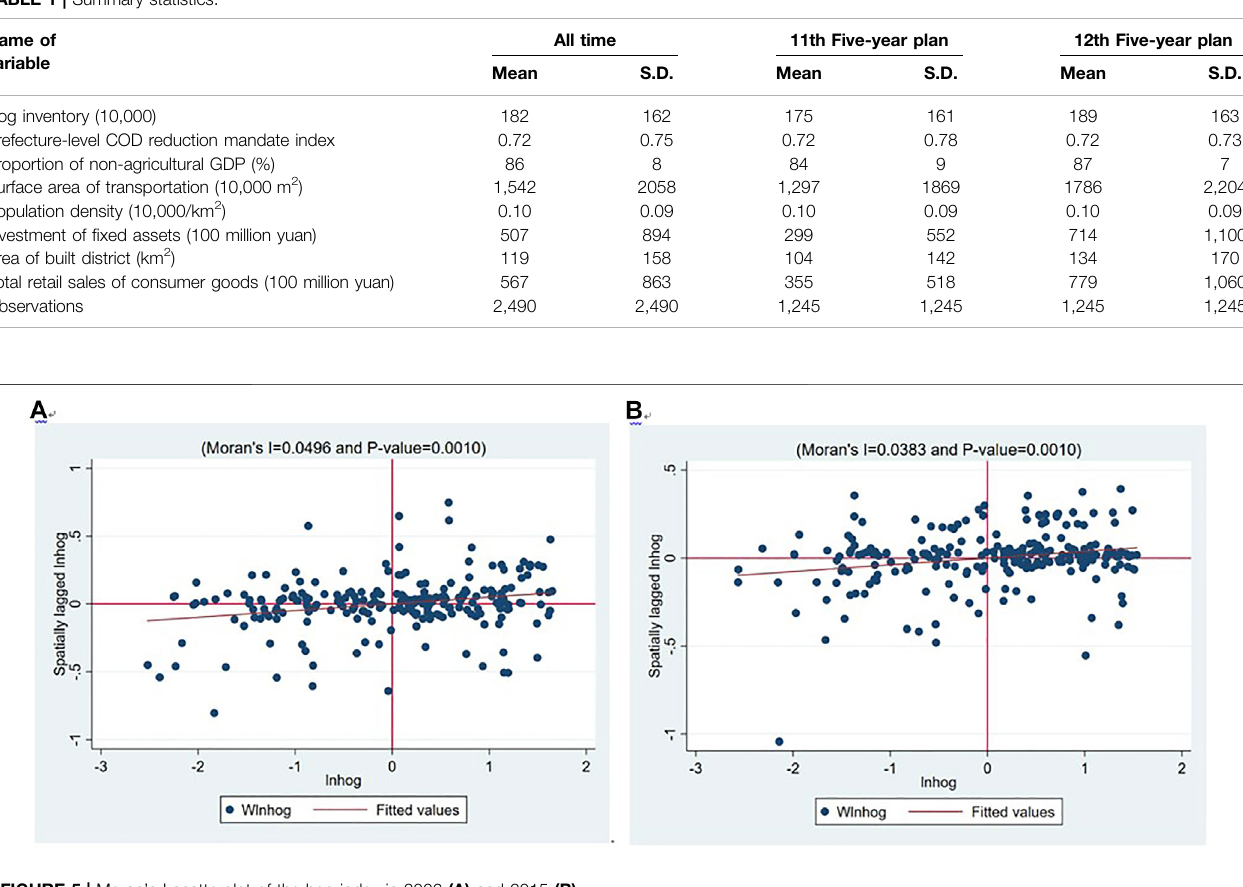
FIGURE 5 | Moran ’ s I scatterplot of the hog index in 2006 (A) and 2015 (B)